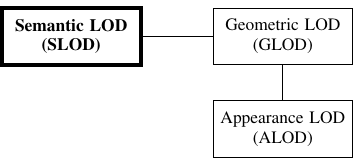
Figure 6. Integration of SLOD, GLOD, and ALOD